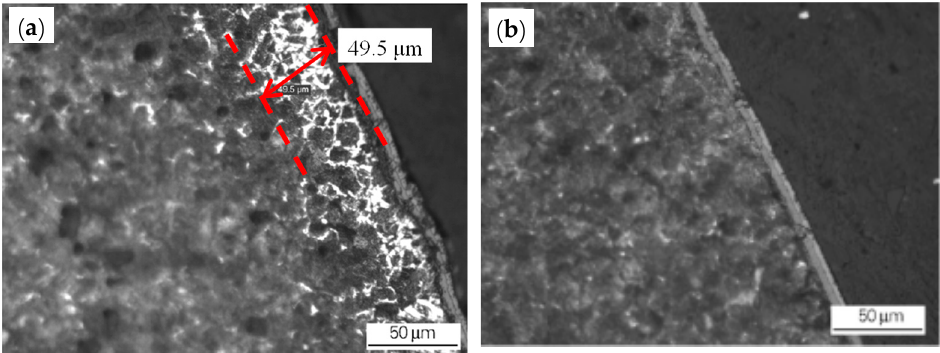
Figure 3. Effect of the grinding of the blank surface on the decarburization layer of the rolled wire rod: ( a ) blank (unpolished) surface and ( b ) the decarburized layer on the polished surface of the rolled wire rod. Reprinted with permission from ref. [10].